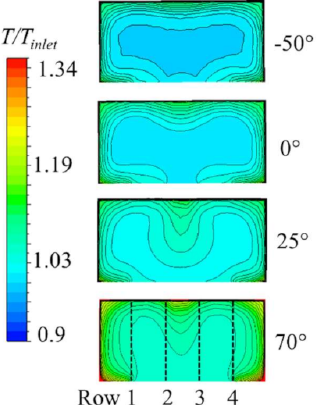
Figure 12. Cross-sectional temperature profiles for single–entry case at 100% mass flow rate condition, at four circumferential positions showing development of secondary flow vortices. Direction of flow is perpendicular to the